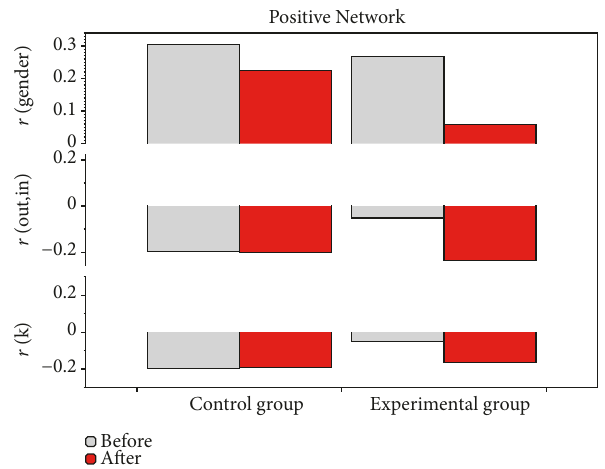
Figure2:PNassortativitymeasure. r (gender)(top), r (out,in)(mid), and r ( k ) (bottom) for control group (left) and experimental group